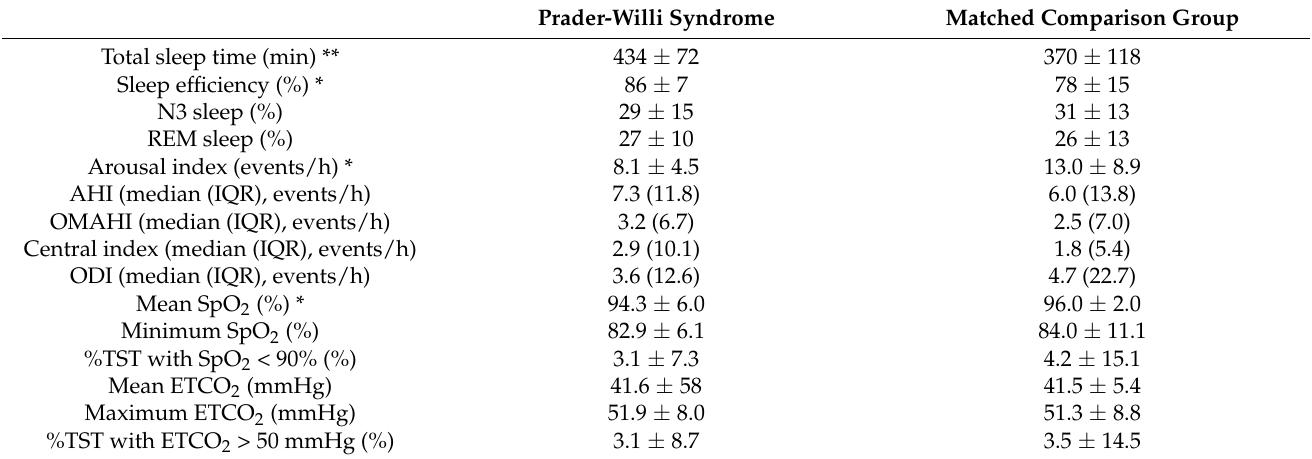
Table 3. Polysomnography results for children with Prader-Willi syndrome and matched comparison group.